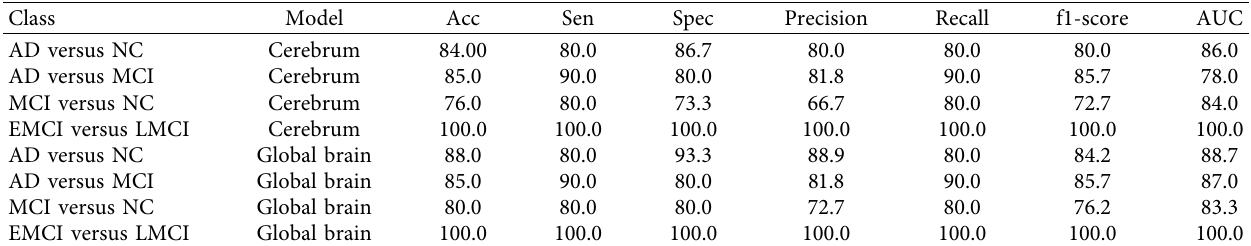
Table 4: Experimental results of adjusting parameters by grid search method